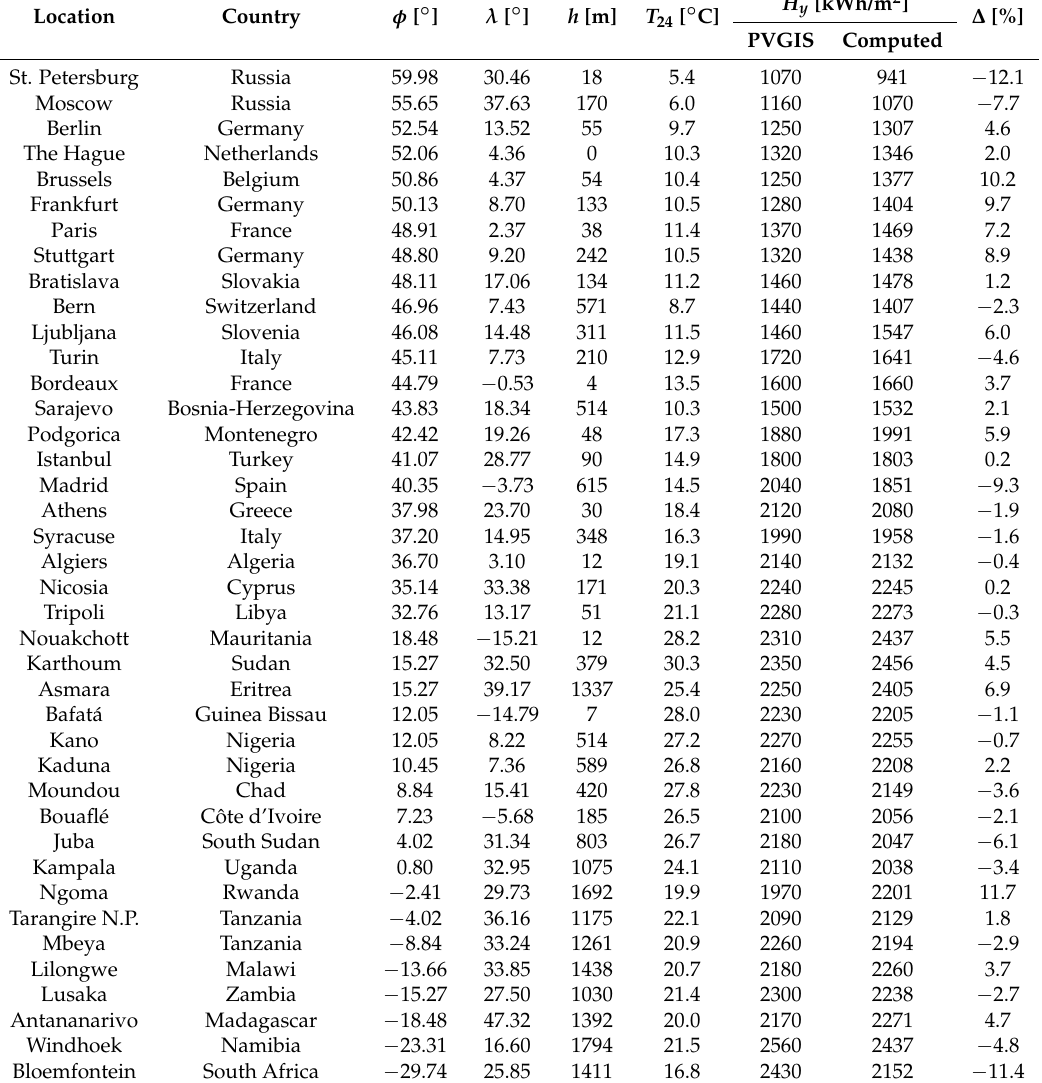
Table A2. Locations in Europe and Africa considered to train and validate the multiple-regression method. For each location, latitude ( φ ), longitude ( λ ), altitude ( h ), and mean temperature over 24 h ( T 24 ) are reported. The yearly sum of the global solar irradiation ( H y ) as obtained from the PVGIS tool [37] and the proposed estimator are compared. The last column reports the relative error of the estimates with respect to the PVGIS data. Note that the exact geographical coordinates have been chosen based on the availability of the required data, and the indicated cities/places represent the most significant locations nearby the considered geographical